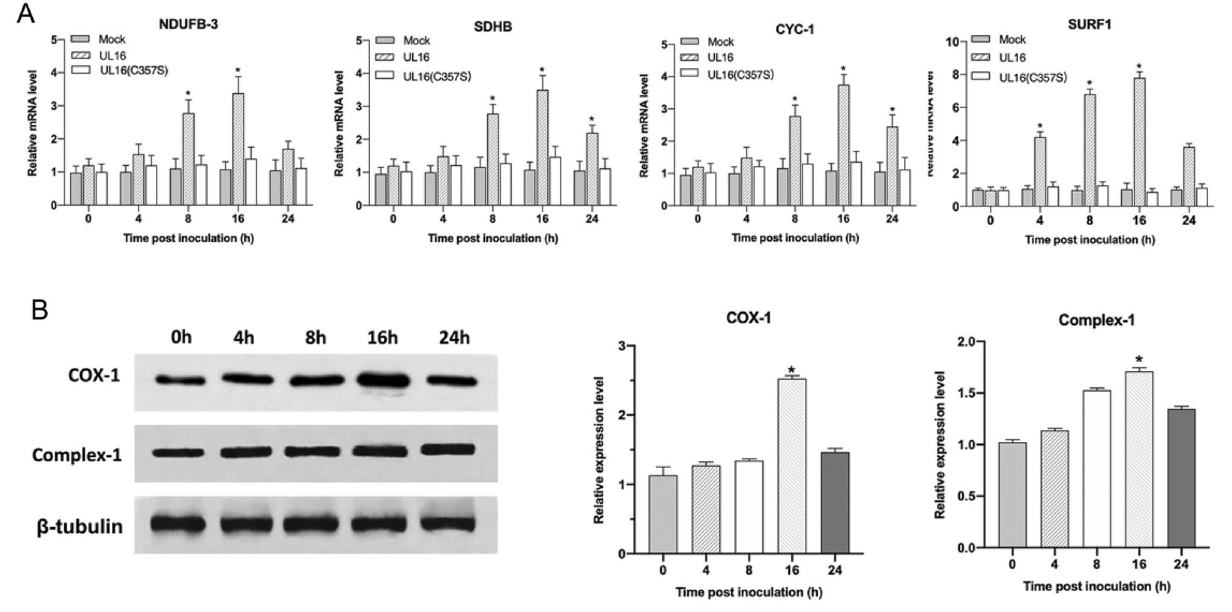
Methods. ( B ) Additionally, cells were lysed at indicated times and immunoblotted using anti-Complex I, COX I, and β-tubulin antibodies. Each value represents the mean of triplicates and barsindicate standard